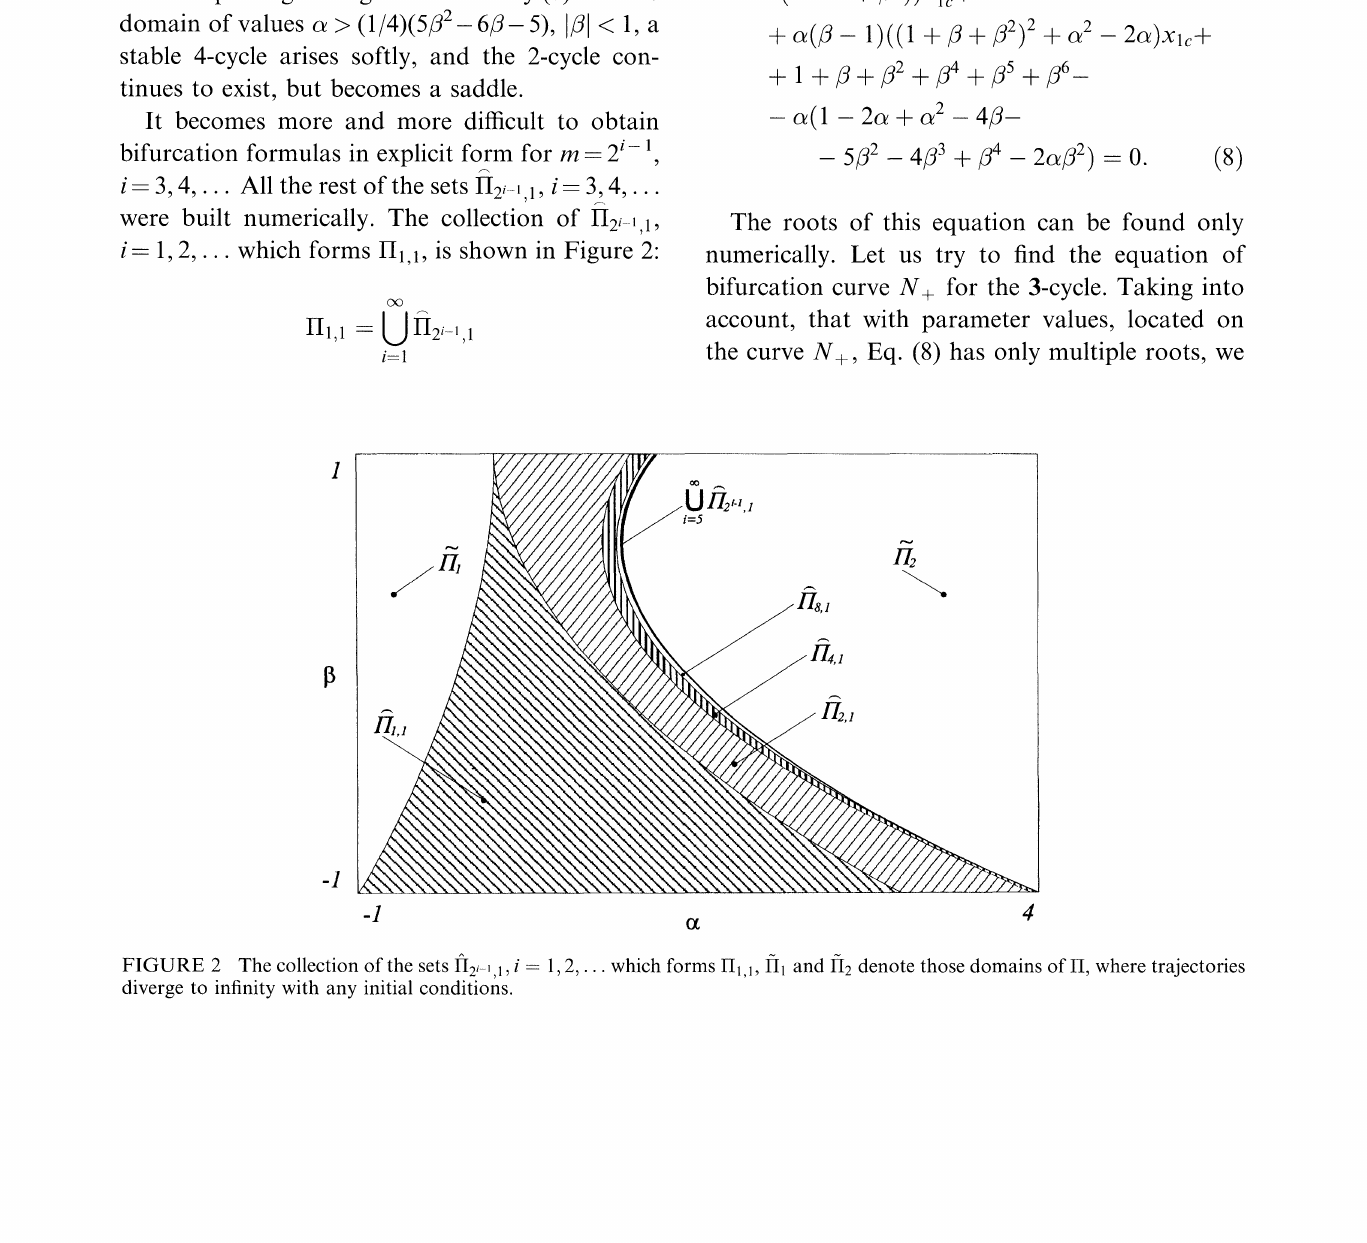
FIGURE 2 The collection of the sets I]2,-,,1, 1,2,... which forms 1-I,1, I] and I denote those domains of H, where trajectories diverge to infinity with any initial